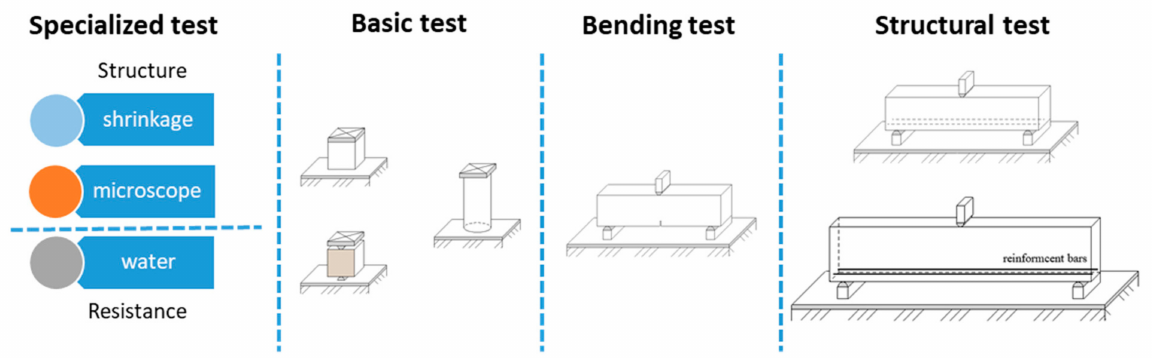
Figure 1. Concept of the experimental program used in this study.